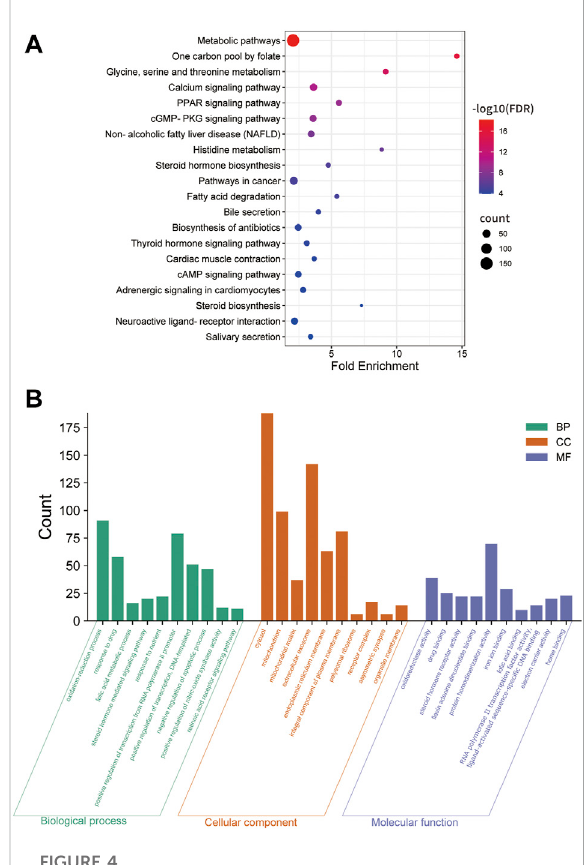
FIGURE 4 KEGG enrichment, Gene Ontology (GO) enrichment of the DSS targets. (A) Dot bubble plot of the top 20 KEGG pathways enriched by the predicted targets of DSS. The size of these dots represents the number of enriched genes, and the color represents -log 10 (FDR). (B) Histogram plot of the top 10 enriched molecular function, cellular component and biological process of DSS targets. BP: biological processes; CC: cellular components; MF: molecular